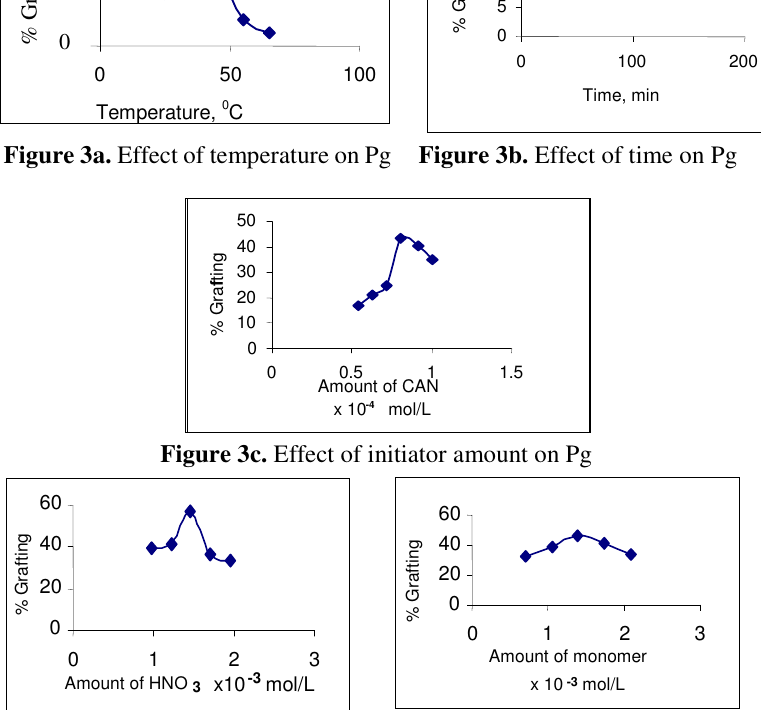
Figure 3d. Effect of Figure 3e. Effect of monomer on Pg